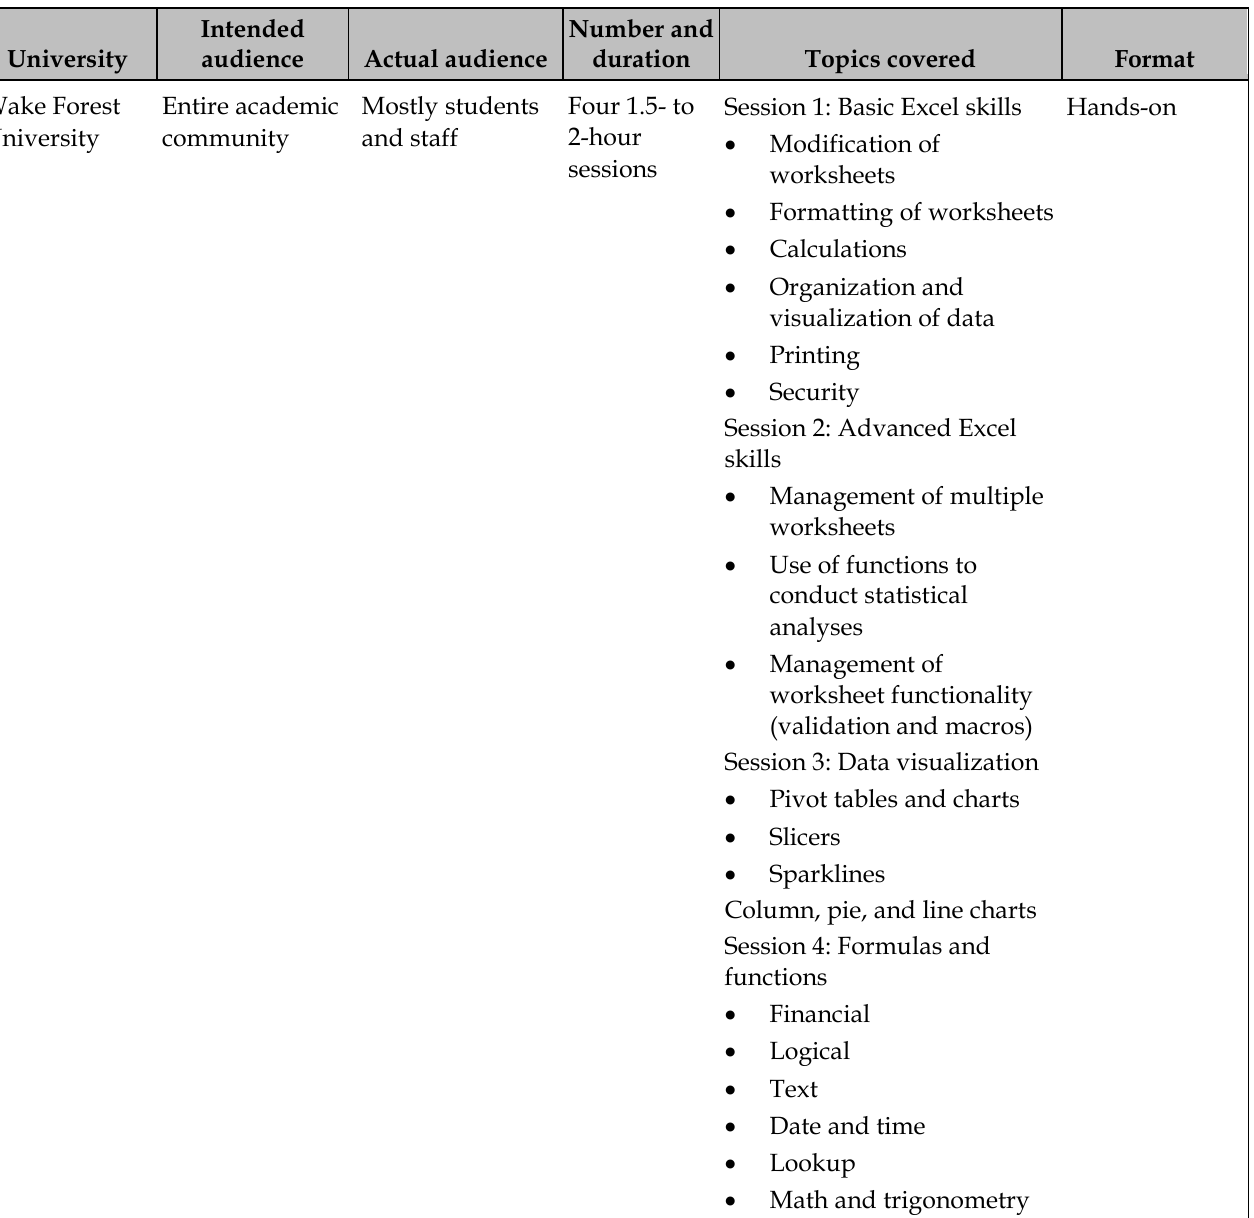
Table 1 Description of Excel-focused data visualization workshops offered by eight institutions